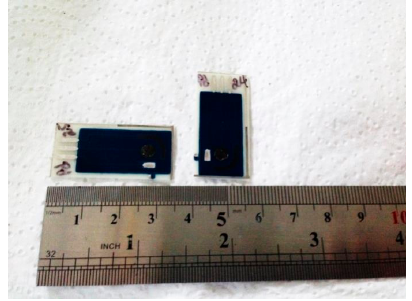
Figure 1. Screen printed electrodic system used.